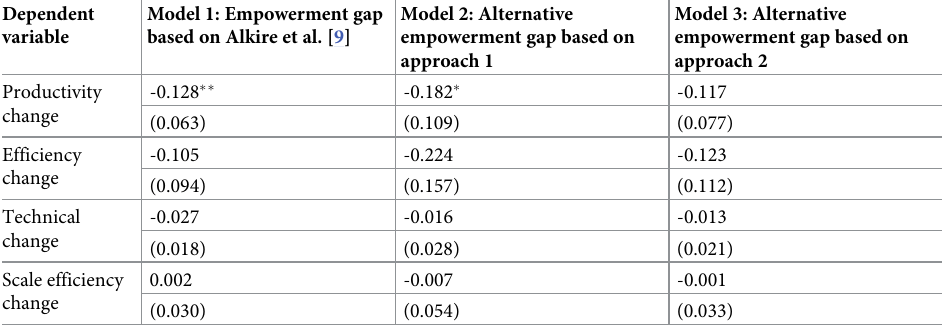
Table 7. Results of the OLS bootstrap regression of the determinants of farm productivity change and its compo- nents (Empowerment